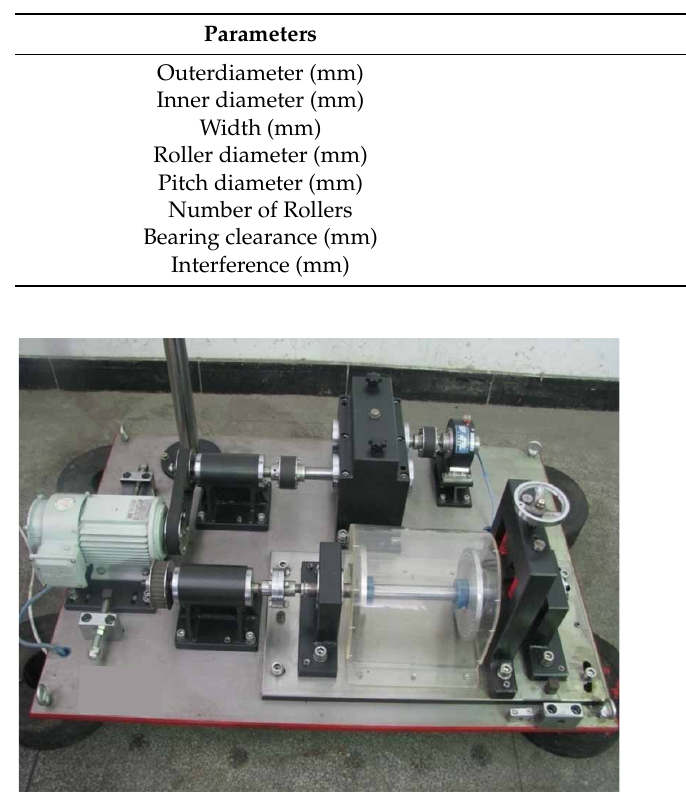
Table 4. Basic parameters of the N205.